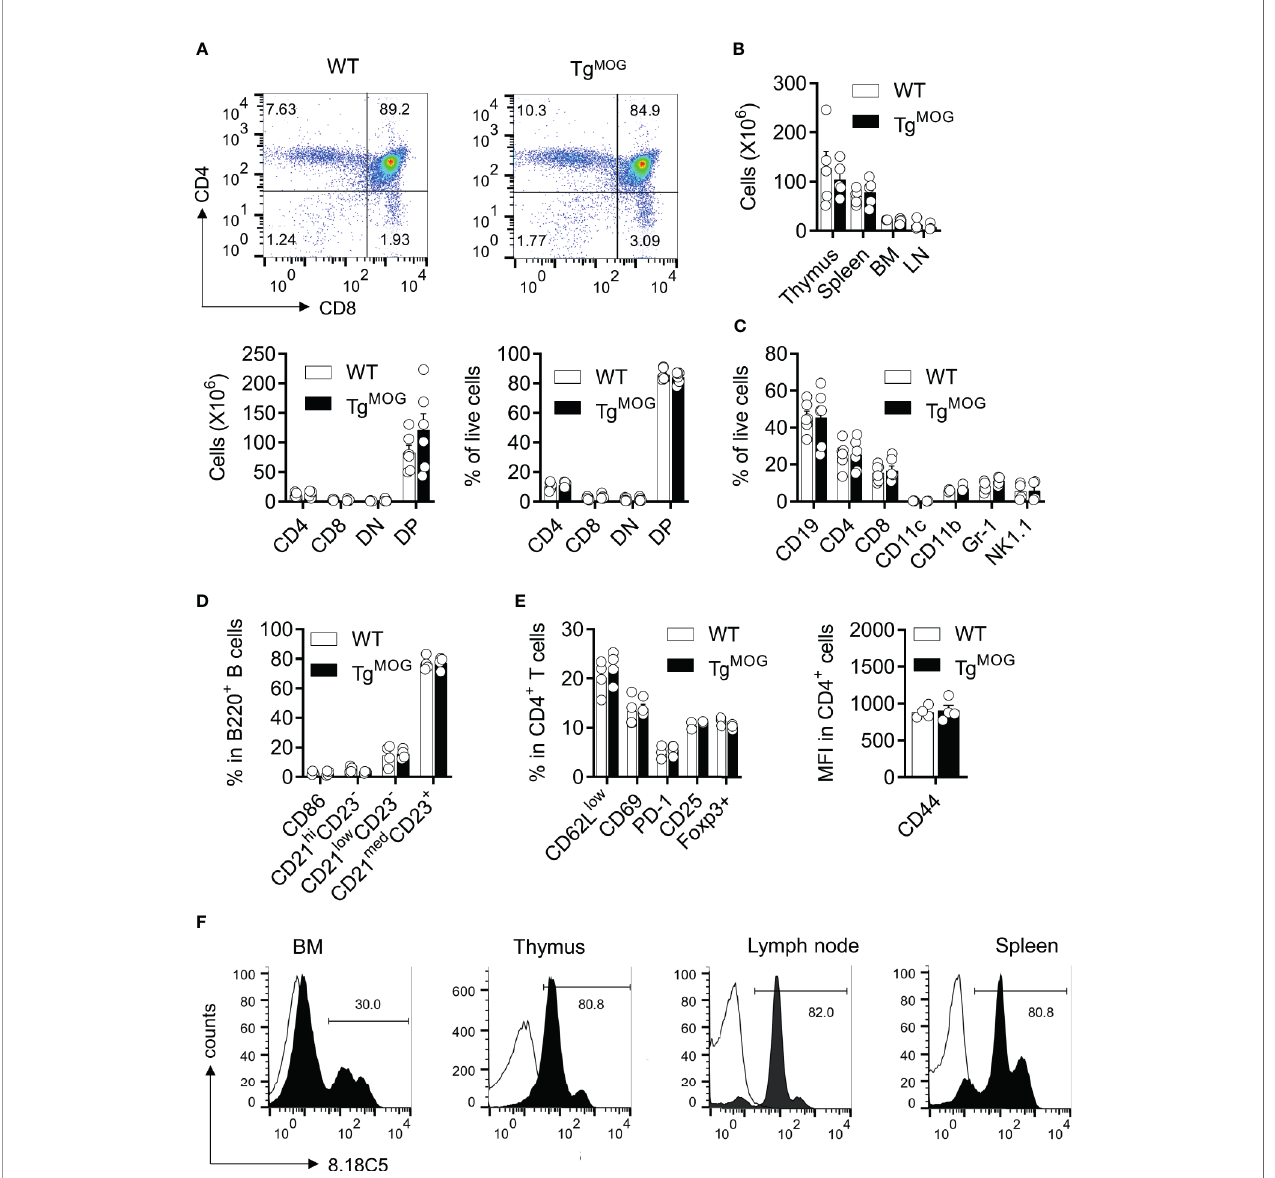
FIGURE 1 | Lymphoid development in Tg MOG mice. (A) Flow cytometry analysis of thymus from Tg MOG and WT non-transgenic littermates. Representative plots are shown (top). Frequencies and total numbers of CD4 + , CD8 + , DN (CD4 – CD8 – ), and DP (CD4 + CD8 + ) T cells are depicted (bottom). (B) Cellularity of thymus, spleen, lymph nodes (LN), and bone marrow (BM). (C) Immune cell composition of the spleen from Tg MOG and WT mice. Frequencies of CD19 + , CD4 + , CD8 + , CD11c + , CD11b + , Gr-1 + and NK1.1 + cells in the live gate are shown. (D) B cell subsets in the spleen of Tg MOG and WT mice. Frequencies of CD86 +, CD21 hi CD23 – , CD21 low CD23 – , CD21 med CD23 + cells in gated B220 + cells are shown. (E) Activation marker expression in splenic CD4 + T cells. Frequencies of CD62L low , CD69 + , PD-1 + , CD25 + , Foxp3 + cells (left) or mean fl uorescence intensity (MFI) of CD44 expression (right) in gated CD4 + cells are shown. (F) Representative fl ow cytometry histograms showing membrane MOG expression in lymphoid organs. (A – E) The combined data from two independent experiments is shown. n = 4 - 6 mice each group. Each circle represents an individual